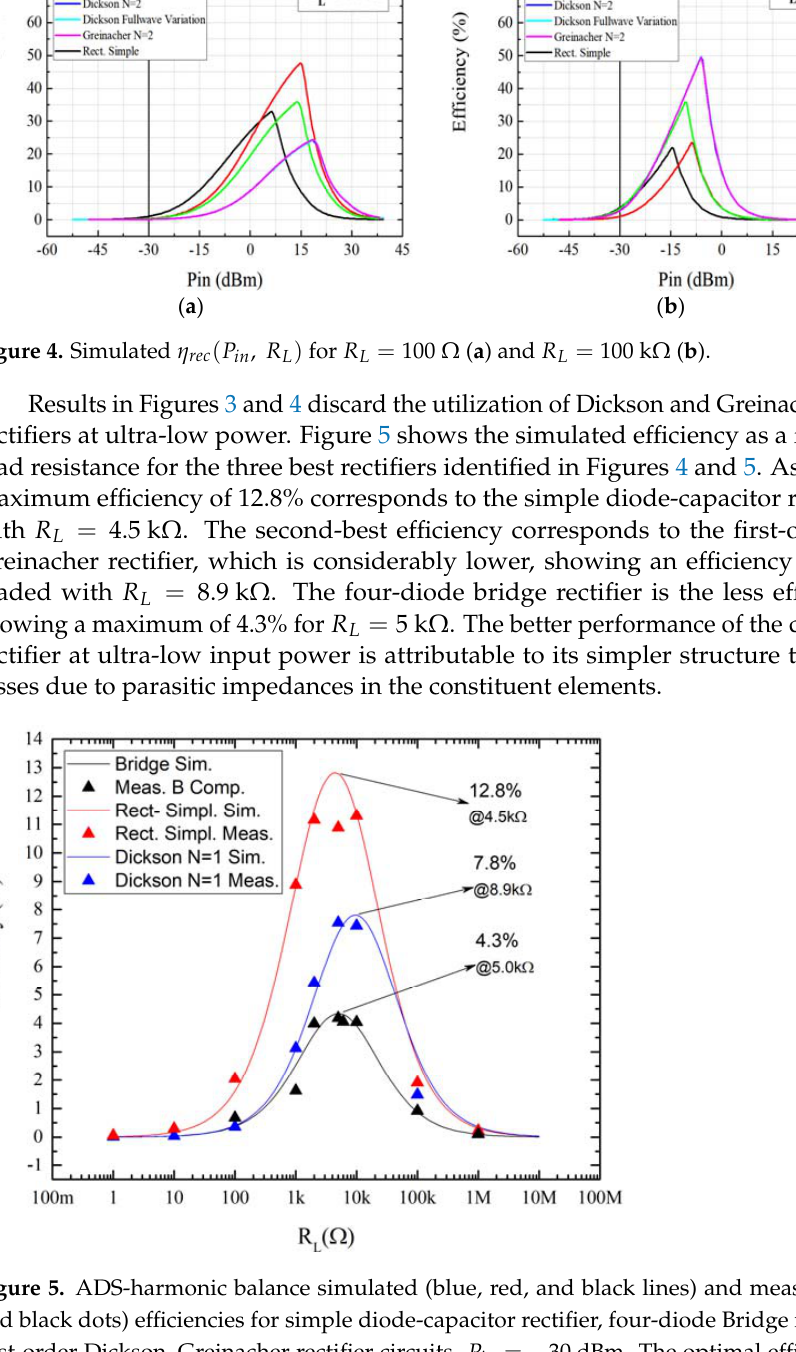
= 100 Ω ( a ) and R L